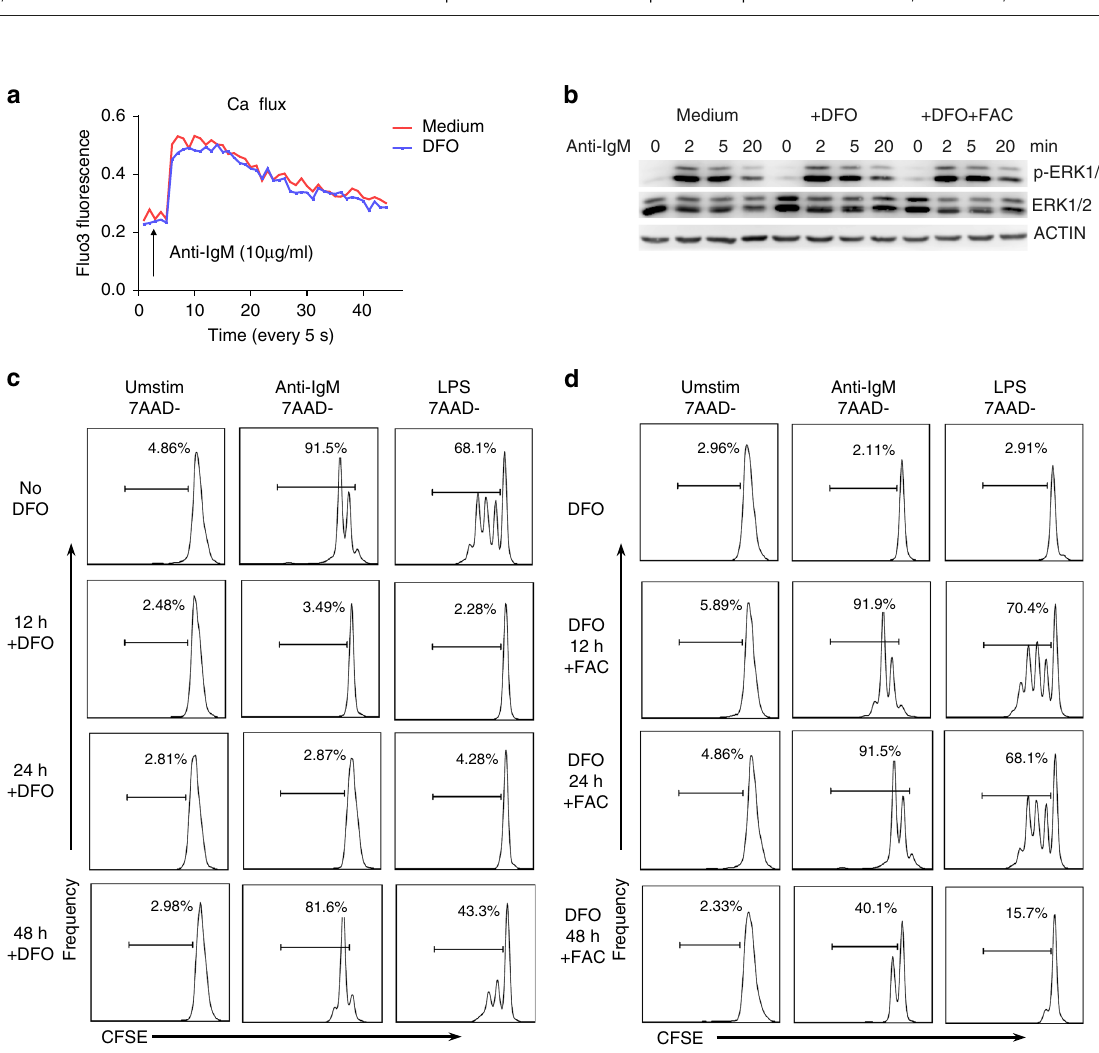
Fig. 4 Iron is required for rapid B-cell proliferation and plasma cell formation in vitro. a Proliferation of splenic B cells cultured in normal medium or in the presence of DFO (20 μ M), DFO accompanied by FAC (100 μ M), or FAC alone (100 μ M) and unstimulated or stimulated with anti-CD40 (1 μ g/ml), anti- IgM (10 μ g/ml) or LPS (2 μ g/ml) for 72 h. B-cell proliferation was assessed by [ 3 H] thymidine incorporation. b The number of viable B cells in a was counted. c Cell division (CFSE dilution) of CFSE-labeled B cells unstimulated or stimulated with anti-IgM (10 μ g/ml) or LPS (2 μ g/ml) under different iron conditions. Cells that underwent at least one cellular division are outlined. d Cell survival (7AAD-) and cell division of CFSE-labeled splenic B cells unstimulated or stimulated with anti-CD40 (1 μ g/ml) or BAFF (100 ng/ml) in the presence or absence of DFO (20 μ M). e Splenic B cells were puri fi ed from wild-type C57BL/6 mice, stimulated for 5 days with LPS under different iron conditions, and stained with anti-B220 and anti-CD138 (a plasma cell marker). The outlined areas indicate plasma cells (B220 low CD138 + ). f Human B cells were isolated from peripheral blood of iron-de fi cient subjects and